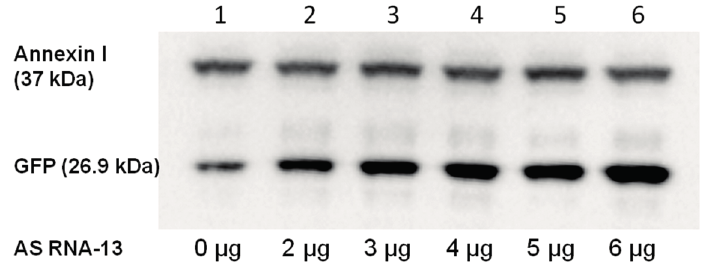
Figure 4. Detection of full-length GFP restoration by western blot analysis. The corresponding band for GFP is visible at a size of ~27 kDa on the nitrocellulose membrane after immunostaining. The amount of detected GFP increases with the amount of added AS RNA-13 (lanes 1–6: 0, 2–6 µg AS RNA-13). Analysis of the intensity of GFP signal revealed an up to eight-fold (relative quantification of GFP expression was measured using the Image Lab 3.0.1 software (Bio-Rad, Hercules, CA, USA) up-regulation after the addition of 6 µg AS RNA-13 expressing plasmids. Annexin I was included as loading control in the experiment visible at a size of 37 kDa on the nitrocellulose membrane.